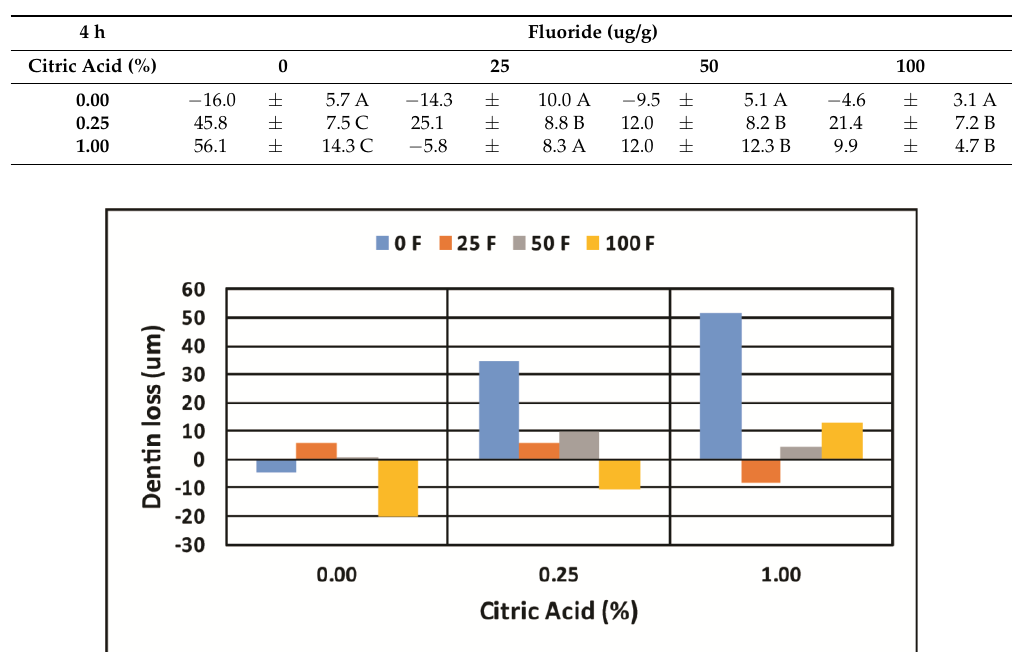
Figure 4. The amount of surface lost at 1 h of erosive challenge in the 12 experimental CA/F solutions. Negative values indicate surface gain, positive values indicate erosive loss of the dentin surface. Dent. J. 2017 , 5 , 27